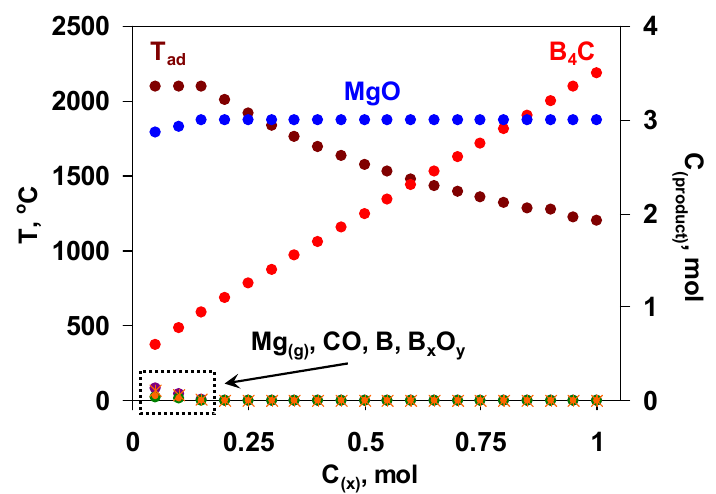
Figure 1. The diagram of the thermodynamic calculations in the B 2 O 3 + xMgB 12 + (3x + 0.5)C + (3-x)Mg mixtures; left axis—T ad , right axis—MgO, B 4 C, Mg (g) , CO, B, B x O y„ P = 0.5 MPa.